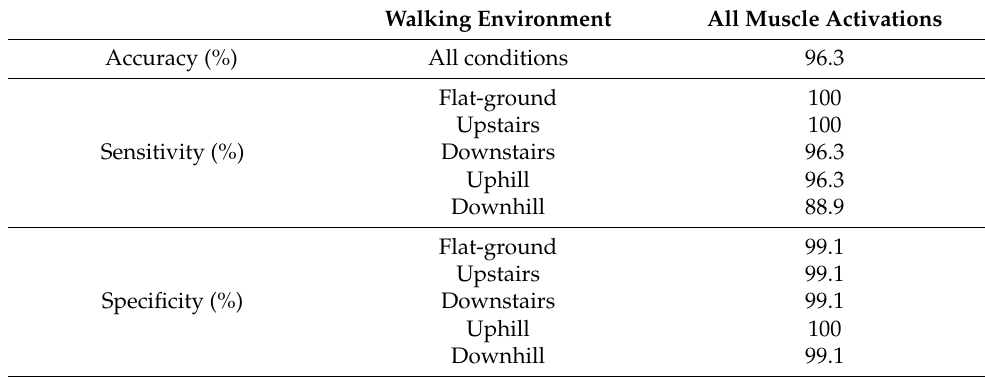
Table 4. The accuracy, sensitivity, and specificity of the model when using all muscle profiles.